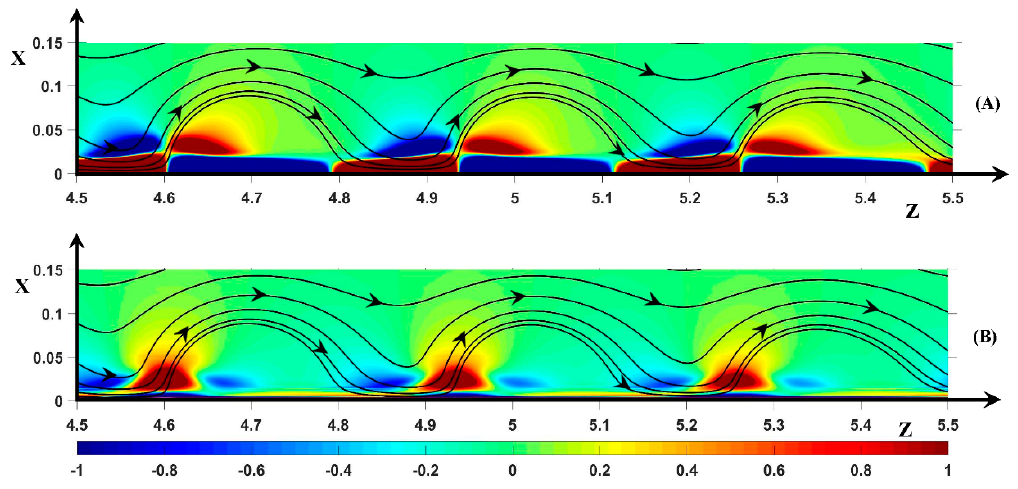
→ →   F Tot ) F Tot ) B ) ( ; ( B ) ( ) Tot x F . Black lines: static streamlines starting from the inlet. z ; ( x . Black lines: static streamlines starting from the inlet.